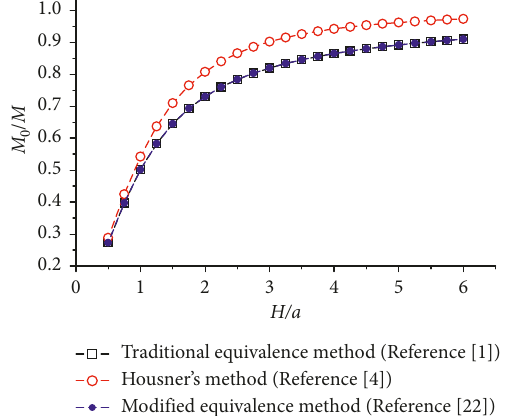
Figure 5: Mass ratio M angular tank).